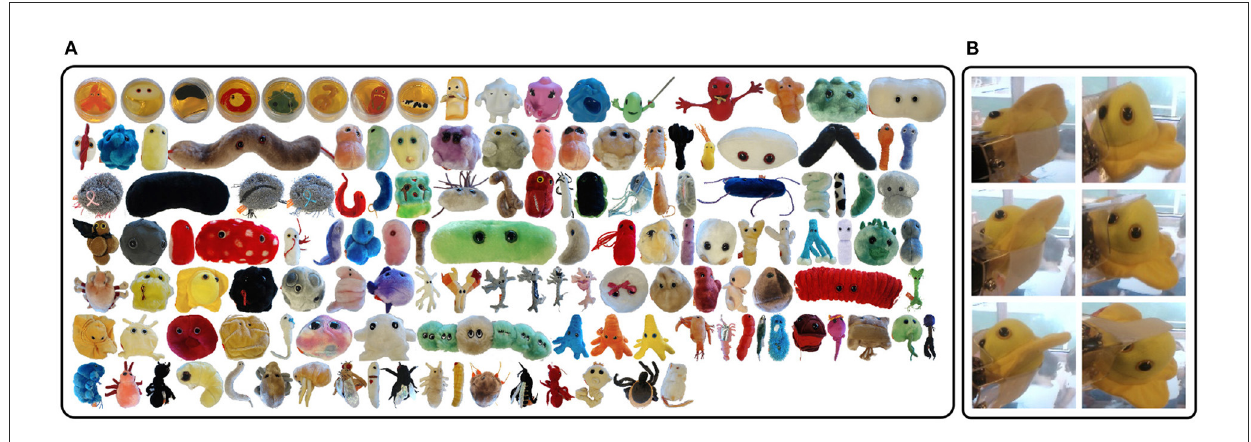
FIGURE4 The GERMS dataset. (A) One hundred and thirty six object instances. (B) Recorded images of different joint positions in each